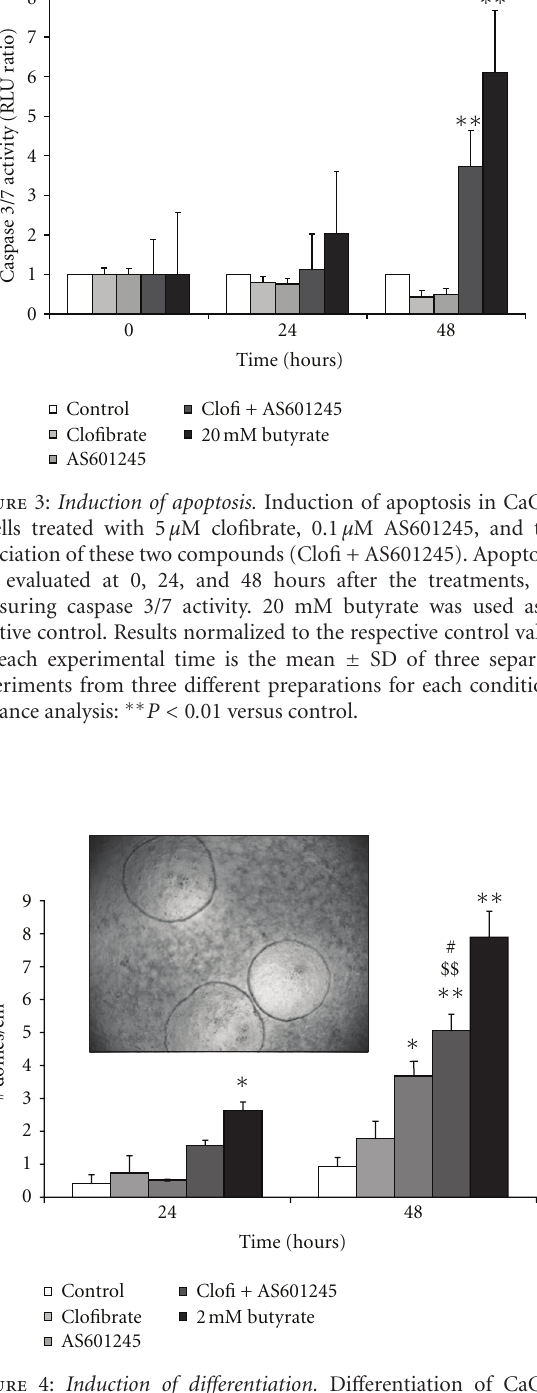
Figure 4: Induction of di ff erentiation. Di ff erentiation of CaCo- 2 cells treated with 5 μ M clofibrate, 0.1 μ M AS601245, and the association of these two compounds (Clofi + AS601245). Cell di ff erentiation was evaluated at 24 and 48 hours after the start of treatments, by measuring dome formation. 2 mM butyrate was used as a positive control. Results, expressed as number of domes per cm 2 , are the mean ± SD of three separate experiments from three di ff erent preparations for each condition. Variance analysis: ∗ P < 0 . 05, ∗∗ P < 0 . 01 versus control; $$ P < 0 . 01, versus clofibrate- treated cells; # P < 0 . 05 versus AS601245-treated cells. The picture represents a microscopic image of domes.